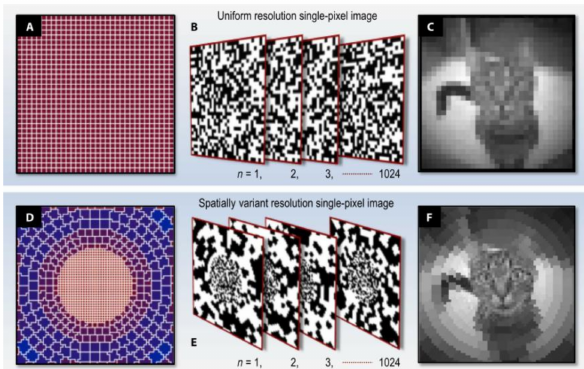
Figure 14. GI with retina-like patterns. ( A ) Uniform grid with 1024 pixels. ( B ) Examples of a complete 1024 pattern. ( C ) The reconstructed image with uniform grid. ( D ) Spatially variant pixel grid with 1024 pixels. ( E ) Examples of a complete 1024 pattern with spatially variant grid. ( F ) The reconstructed image with spatially variant